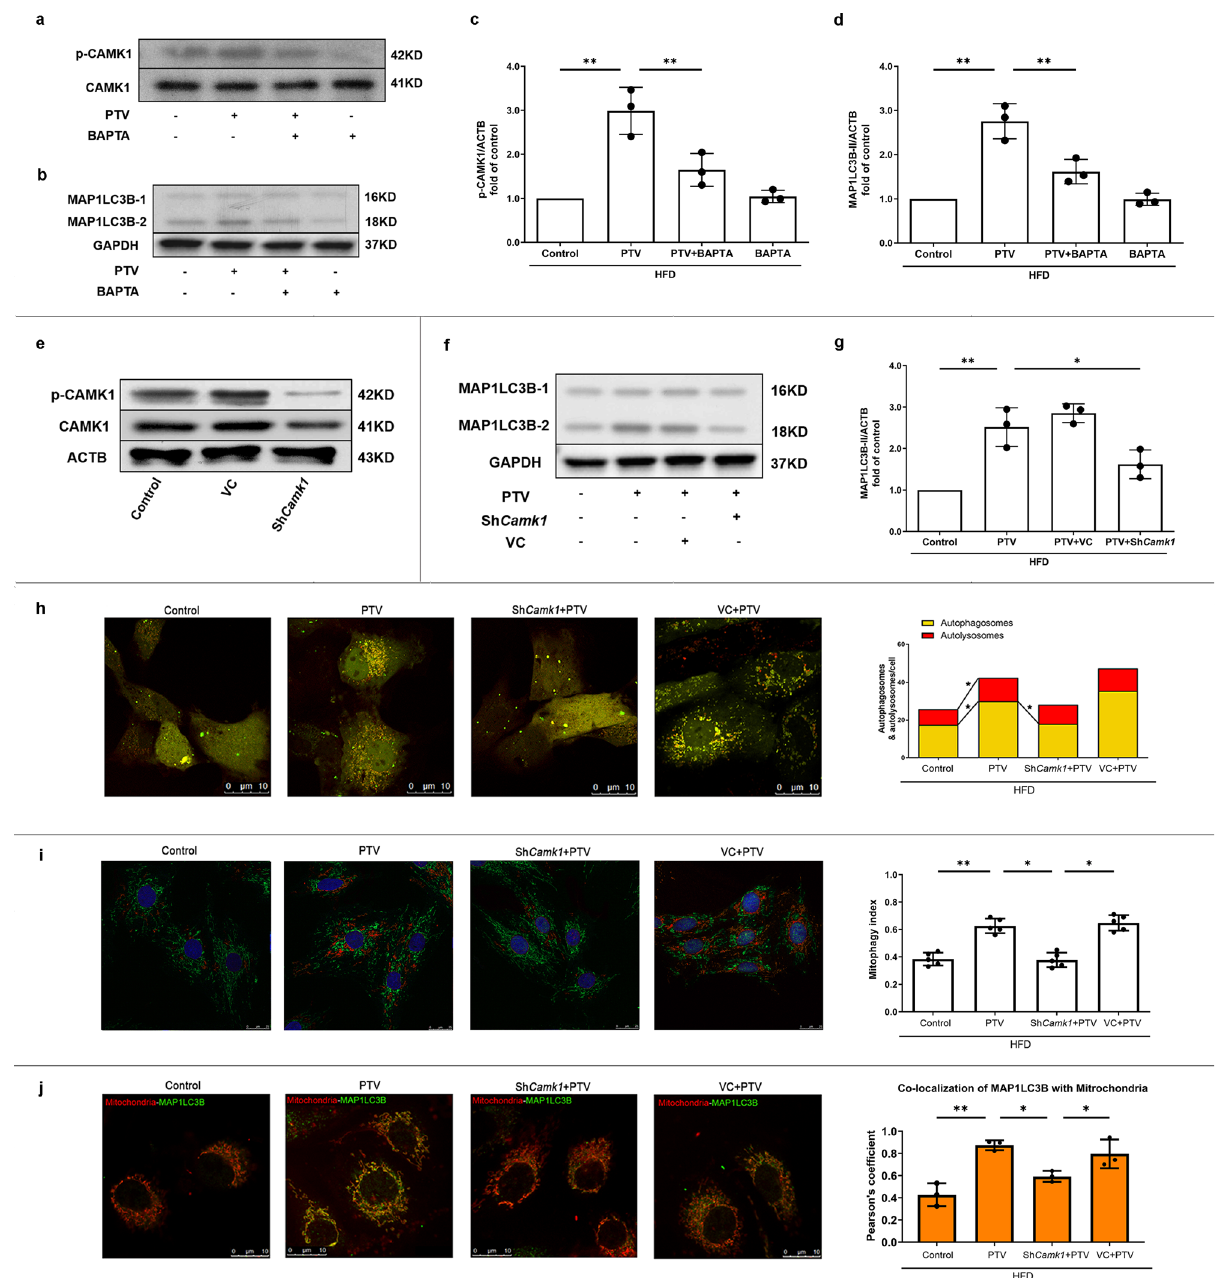
Fig. 7 CAMK1 activation contributes to PTV-induced mitophagy. ( a – d ) EPCs were pretreated with BAPTA-AM (20 mM) for 20 min followed by PTV (0.5 μ M) for 24 h. Representative western blots ( a ) and quantitative analysis ( c ) indicated that BAPTA-AM signi fi cantly decreased PTV-induced CAMK1 phosphorylation at Thr 177 site. Representative western blots ( b ) and quantitative analysis ( d ) indicated that BAPTA-AM signi fi cantly decreased the expression of MAP1LC3B-II induced by PTV. e Lentiviral vector carrying Camk1 shRNA was employed to knockdown Camk1 in EPCs. Representative western blots showed that Camk1 was effectively knocked down. Camk1 was knocked down by shRNA for 72 h before PTV treatment. Representative western blots ( f ) and quantitative analysis ( g ) showed that Camk1 knockdown signi fi cantly decreased the expression of MAP1LC3B-II induced by PTV. h EPCs from atherosclerotic mice were transfected by lentivirus to knock down Camk1 . Camk1 knockdown group, control group, and vector control group EPCs were infected by tandem GFP-mRFP-LC3 adenovirus for 24 h before exposure to PTV (0.5 μ M) 24h. Representative LSCM images showed puncta formation in different groups. Scale bar: 10 μ m. Quantitative analysis of yellow and free red puncta. PTV increased the number of yellow and free red puncta compared with control. Camk1 knockdown signi fi cantly decreased the number of yellow puncta increased by PTV. i EPCs from atherosclerotic mice were transfected by lentivirus to knock down Camk1 . All the groups were infected by mtKeima plasmid for 12 h before treatment by PTV PTV (0.5 μ M) 24 h. Representative images showed puncta formation in different groups. Scale bar: 25 μ m. PTV treatment increased the red fl uorescence intensity turnover, indicating that more mitochondria were transferred to lysosomes. This effect was blocked by silencing Camk1 . Quantitative analysis of the fl uorescent area showed that PTV increased mitophagy index, but knock down Camk1 blocked this effect. j Merged images revealed that Camk1 knockdown reduced the co-localization of MAP1LC3B and mitochondria in EPCs according to Pearson ’ s overlap coef fi cient analysis. Scale bar: 10 μ m. ( n = 10 cells per group, EPCs were isolated from 3 ApoE − / − mice fed with high fat diet for 8 weeks and 3 independent experiments were performed, mean ± SD, * P < 0.05, ** P < 0.01).